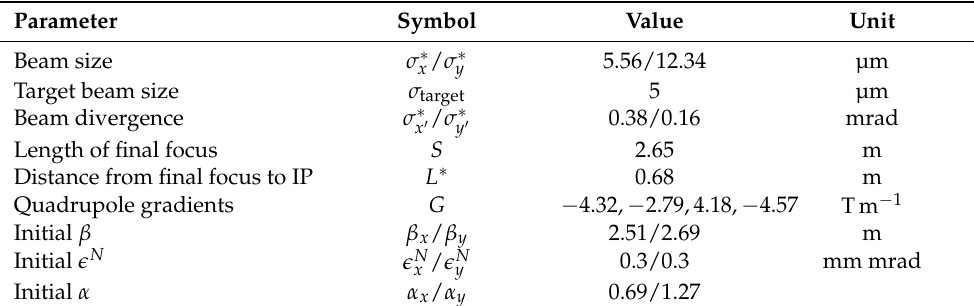
Figure 13. Results of RF-Track simulations of the XLS-based ICS source for an electron beam en- ergy of 100MeV, for each bunch crossing. ( a ) The photon energy spectrum. ( b ) The number of photons/mrad 2 /s against energy and collection angle. ( c ) The X-ray transverse source size. ( d ) The angular emission distribution. Table 7. Parameters used for the final focus design. All beam parameters are at the IP. Output X-ray parameters were also included. The quadrupole gradients were quoted in the order of interaction with the electron